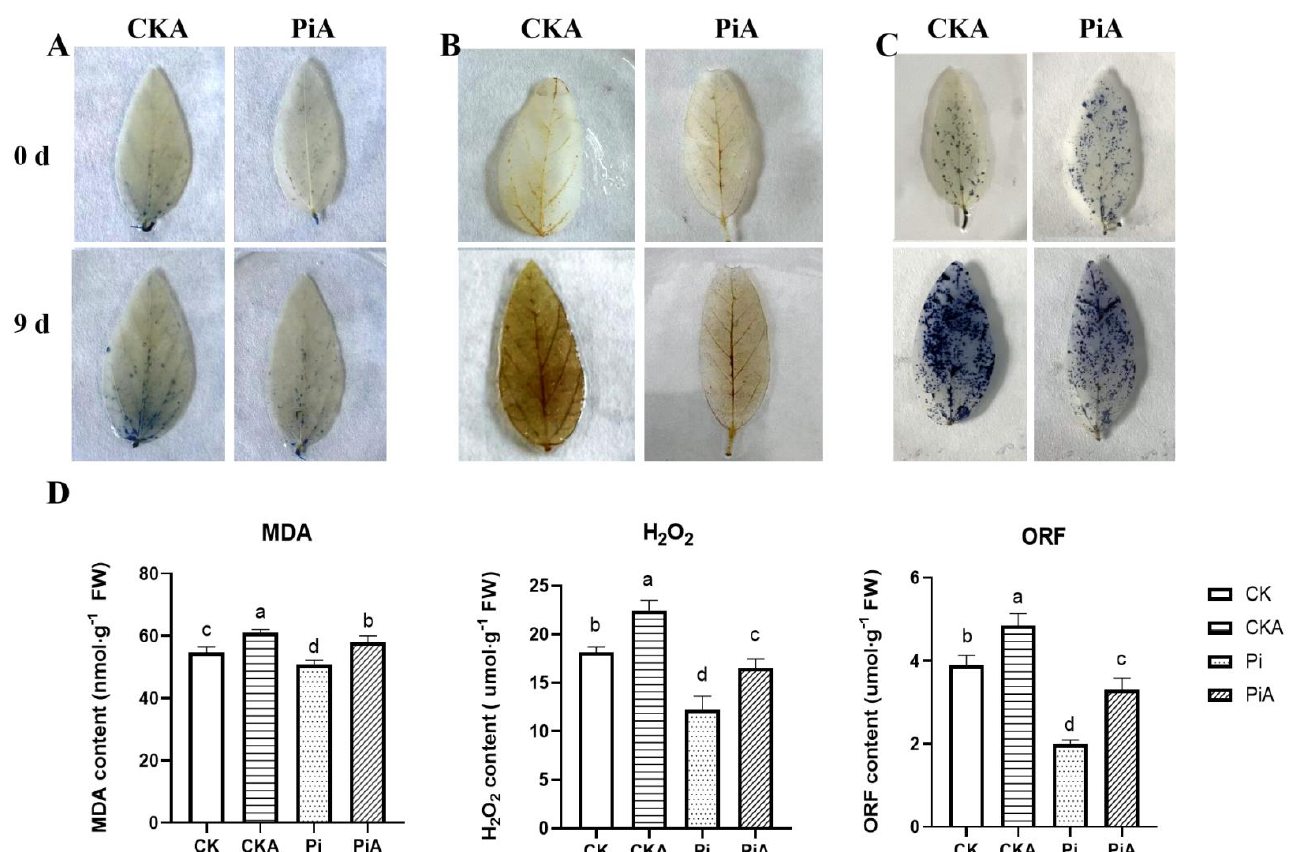
Figure 4. Oxidative damage of soybean inoculated with Piriformis indica (Pi) and control (CK) after salt stress. ( A ) Trypan blue staining, ( B ) DAB (3,3 (cid:48) -Diaminobenzidine), and ( C ) NBT (Nitrotetrazolium blue chloride). ( D ) The contents of malondialdehyde (MDA), H 2 O 2 , and O 2 − (oxygen free radical, ORF). CK: P. indica non-colonized control plants; Pi: plants inoculated with P. indica . CKA: control plants were treated with 200 mmol/L NaCl. PiA: inoculated soybeans were treated with 200 mmol/L NaCl. Different letters above the bars indicate a significant difference ( p < 0.05). Error bars represent SDs (n = 9).